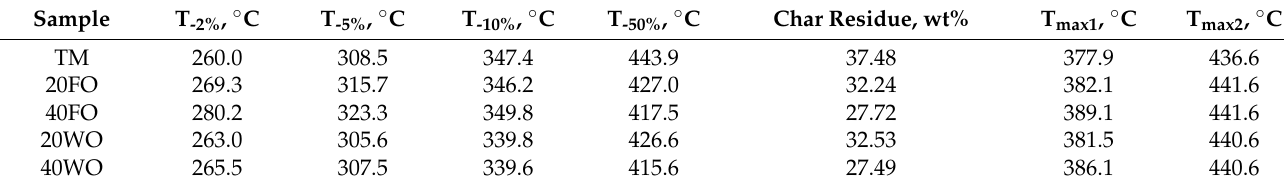
Table 6. The results of thermogravimetric analysis of GTR samples.